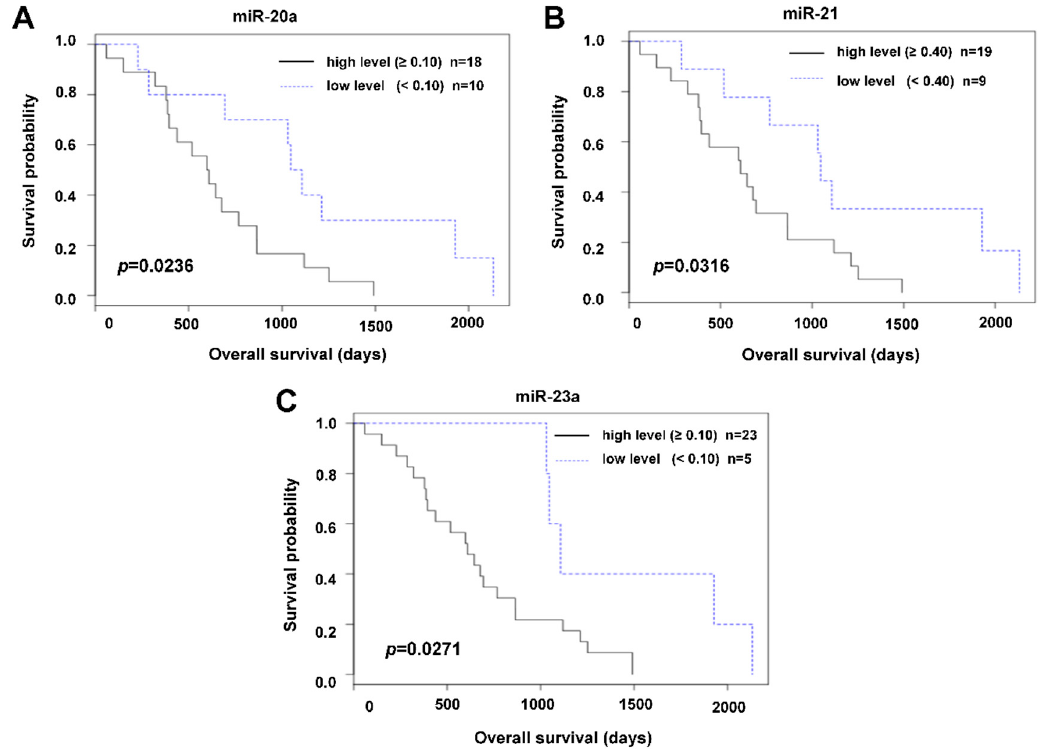
Figure 3. Relation of miR-20a ( A ), miR-21 ( B ), and miR-23a ( C ) preoperative plasma levels to overall